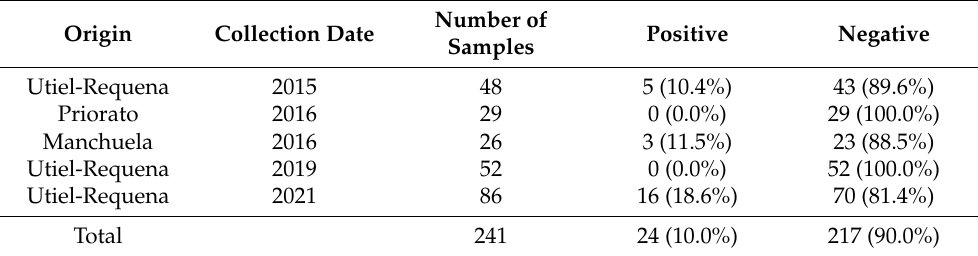
Table 5. Results of the survey performed with the new GLRaV-1 detection